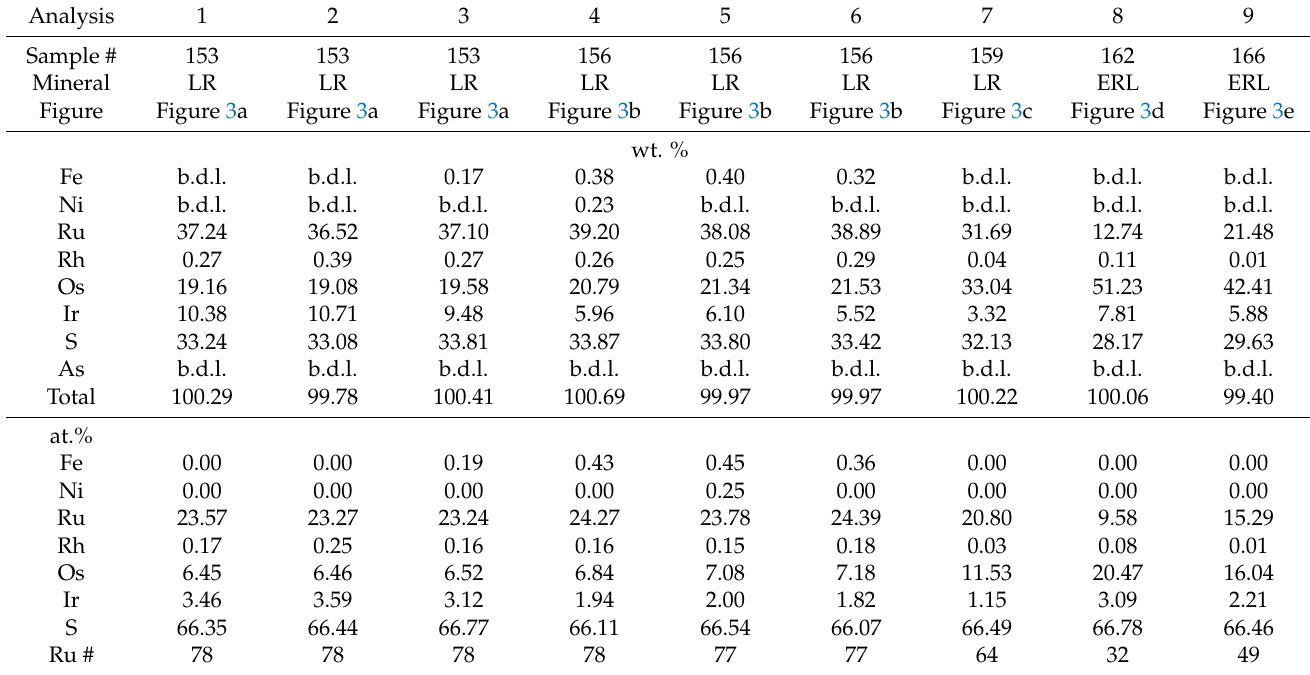
Table 1. Electron microprobe analyses of Ru-Os sulfides of type 1 from the Verkh-Neivinsk massif.